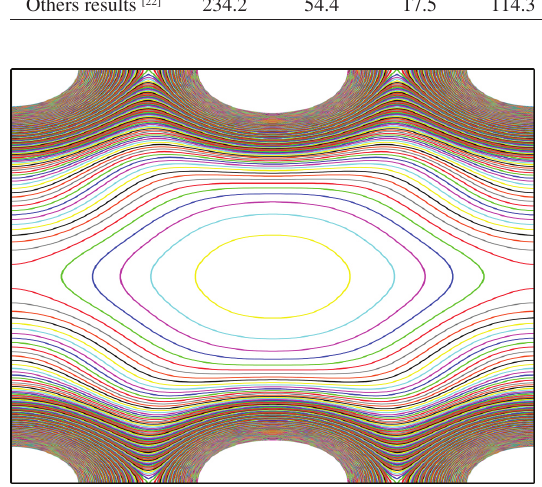
Figure 7. Electron density maps of Cu